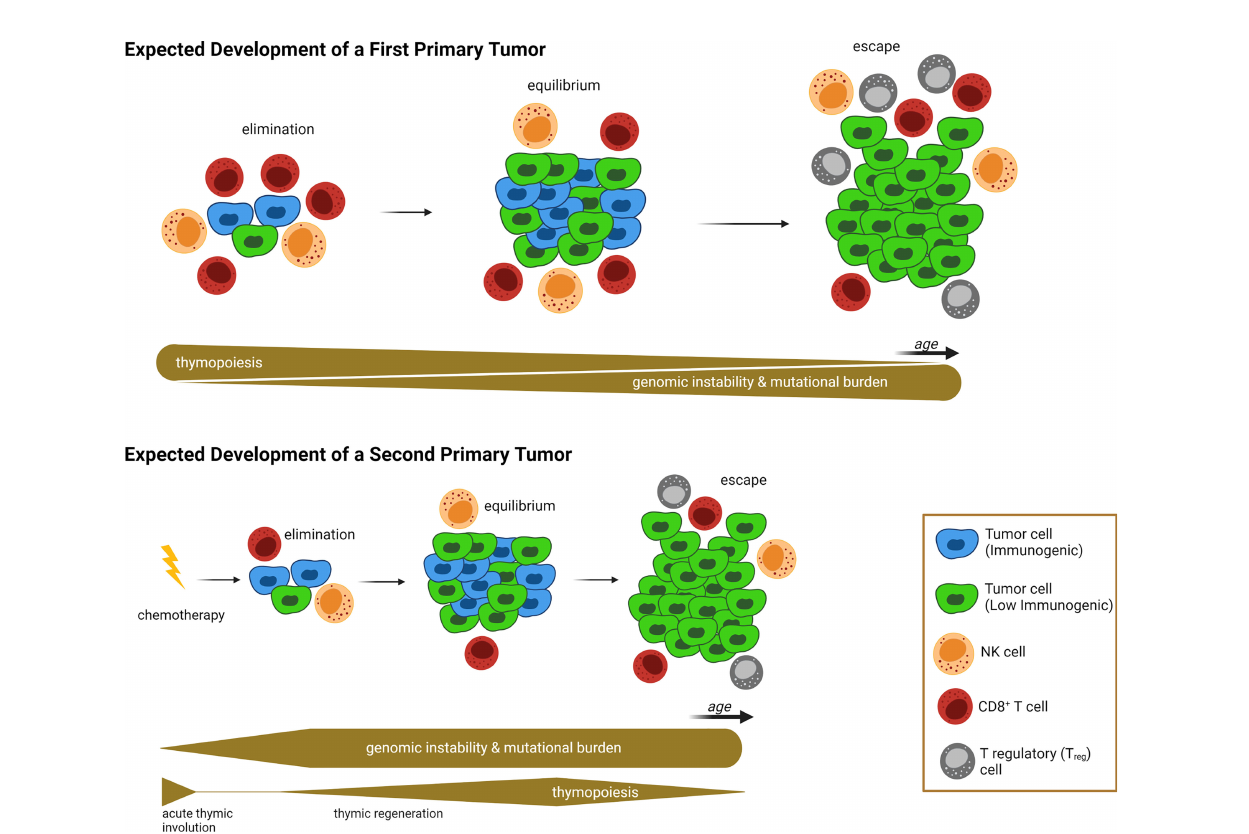
FIGURE 1 | Proposed Link Between Acute Thymic Involution and Development of Second Primary Malignancy. In the absence of exposure to prior treatments with cytoablative chemotherapies due to a fi rst-primary tumor (upper half of illustration), the emergence of nascent transformed cells is subjected to a “ competent ” cancer immunoediting process. At the beginning, the competent immune system can eliminate neoplastic cells via an ef fi cient immune surveillance machinery. Then tumor cell growth is balanced by immunogenic cell death, described as equilibrium phase. And fi nally, immunosculpting leads to the escape phase, during which anticancer immunity fails to control tumor growth and creates a clinically overt tumor. The succession of these three phases is a long-lasting process with two main contributing factors: First, genomic instability is increased over time, leading to accumulation of driver mutations and genetic diversity that allows immunoevasive and immunosuppressive mechanisms to evolve (e.g. development of tumor cell clones with absent or low immunogenicity). At the same time, age-related thymic involution causes a decreased T cell peripheral pool and T cell receptor repertoires, leading to failure of immune surveillance and equilibrium mechanisms. In contrast, following exposure to a fi rst-primary tumor and associated treatment with cytoreductive chemotherapy (lower half of illustration), the failure of the immune surveillance and equilibrium mechanisms occurs at a much earlier timepoint, allowing for the onset of clinically overt second primary malignancies (SPMs) at a younger age, compared to fi rst-primary tumors (compare timelines between upper and lower half of illustration). Contributing factors for the SPM are the genotoxic nature of cytotoxic chemotherapy (which grants genomic instability and mutational burden at a very early onset), and chemotherapy-induced acute thymic involution causing impaired thymopoiesis, T cell receptor repertoires, and peripheral T cell pools, thus weakening immune surveillance mechanisms during elimination and equilibrium phases. Relative thickness of gray bars underneath the timelines in each condition indicates the strength of thymopoiesis (upper bar), and genomic instability (lower bar) over time (not drawn to scale). Illustration designed with Biorender